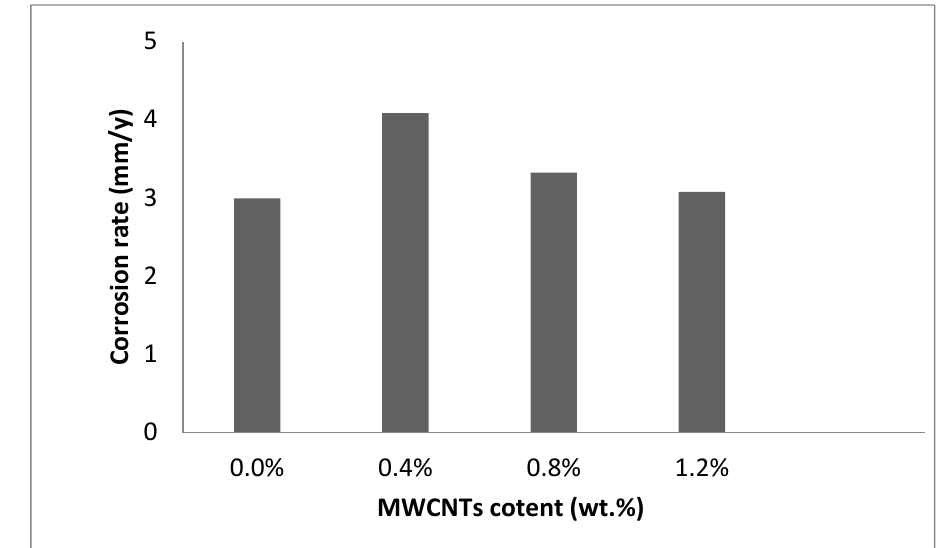
Figure 11. Corrosion rate of Cu-MWCNT nanocomposites.